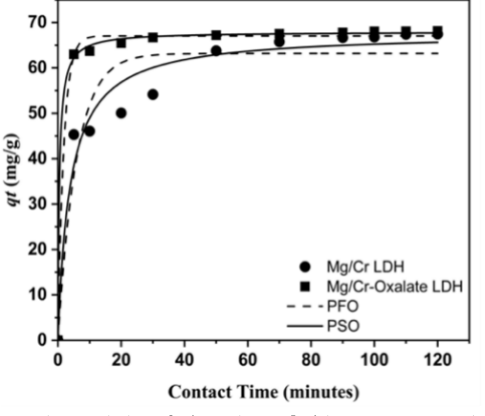
Fig. 5. Time variation of adsorption malachite green onto Mg/Cr LDH and Mg/Cr-Oxalate LDH